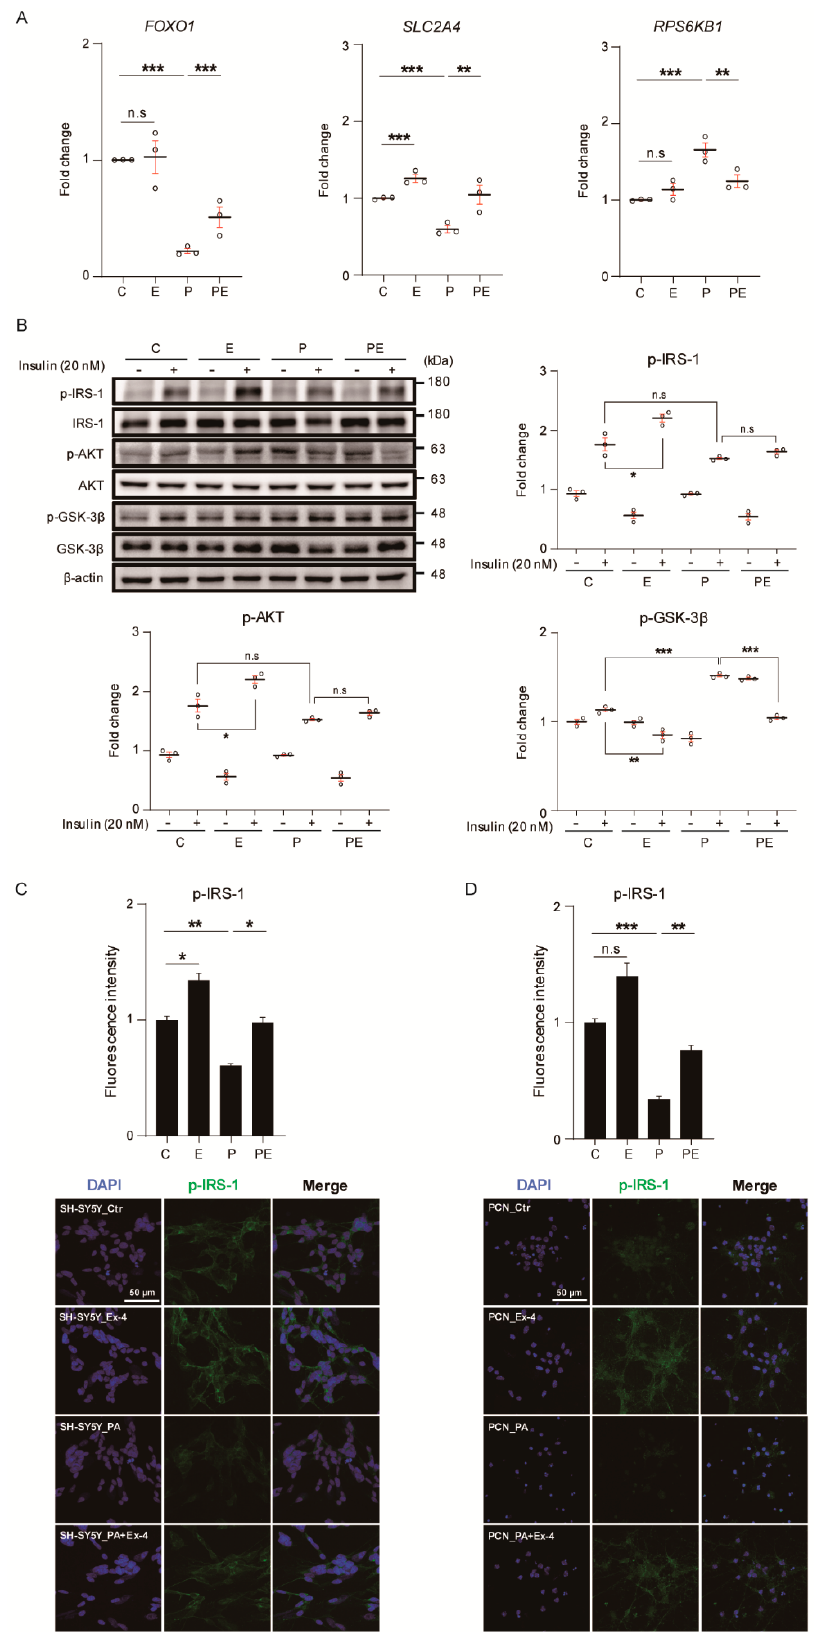
Figure 2. Exendin-4 improves insulin signaling in a neuron under palmitic acid-induced oxidative stress. ( A ) Comparison of mRNA expression levels of insulin signaling related genes ( FOXO1 , SLC2A4 , and RPS6KB1 ) in SH-SY5Y cells treated with vehicle (C or Ctr), Exendin-4 (E or Ex-4), palmitic acid (P or PA), and both palmitic acid and Exendin-4 (PE or PA+Ex-